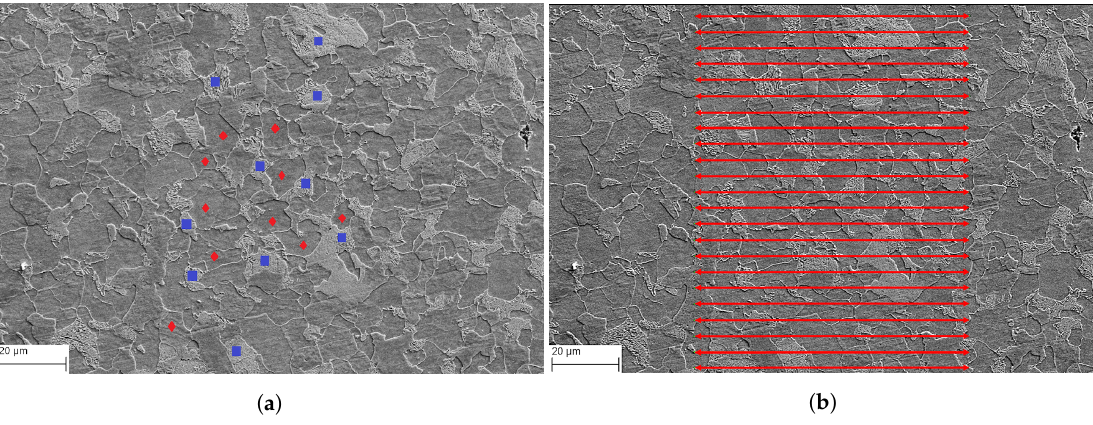
Figure 10. ( a ) Grains used for local strain measurements in Figure 9, where the blue squares are pearlite grains and the red diamonds are ferrite grains. ( b ) Vectors used as virtual extensometer for the average engineering strain over the recorded area, having an initial length of 80